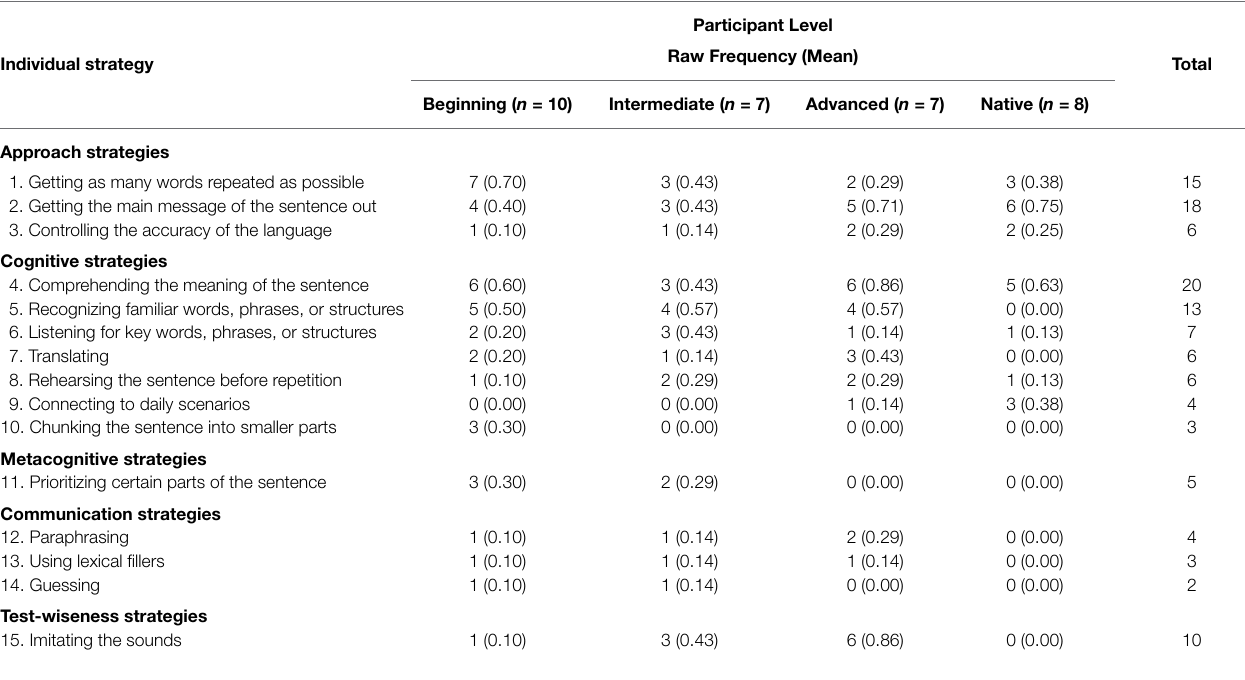
TABLE 3 | Frequencies of individual strategies reported by the